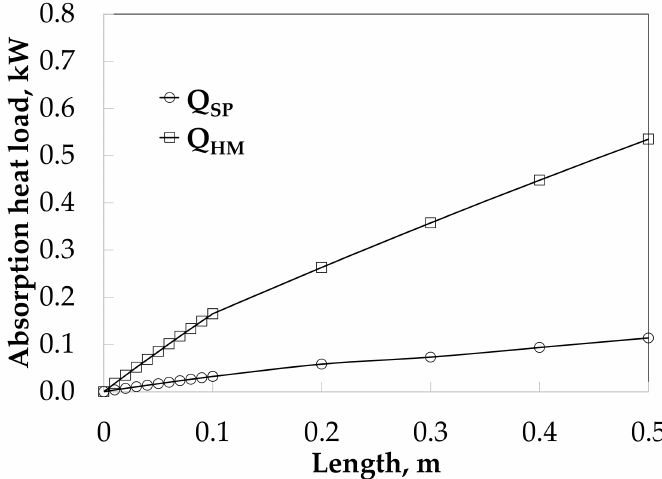
Figure 10. Heat load profiles along the absorber length without and with